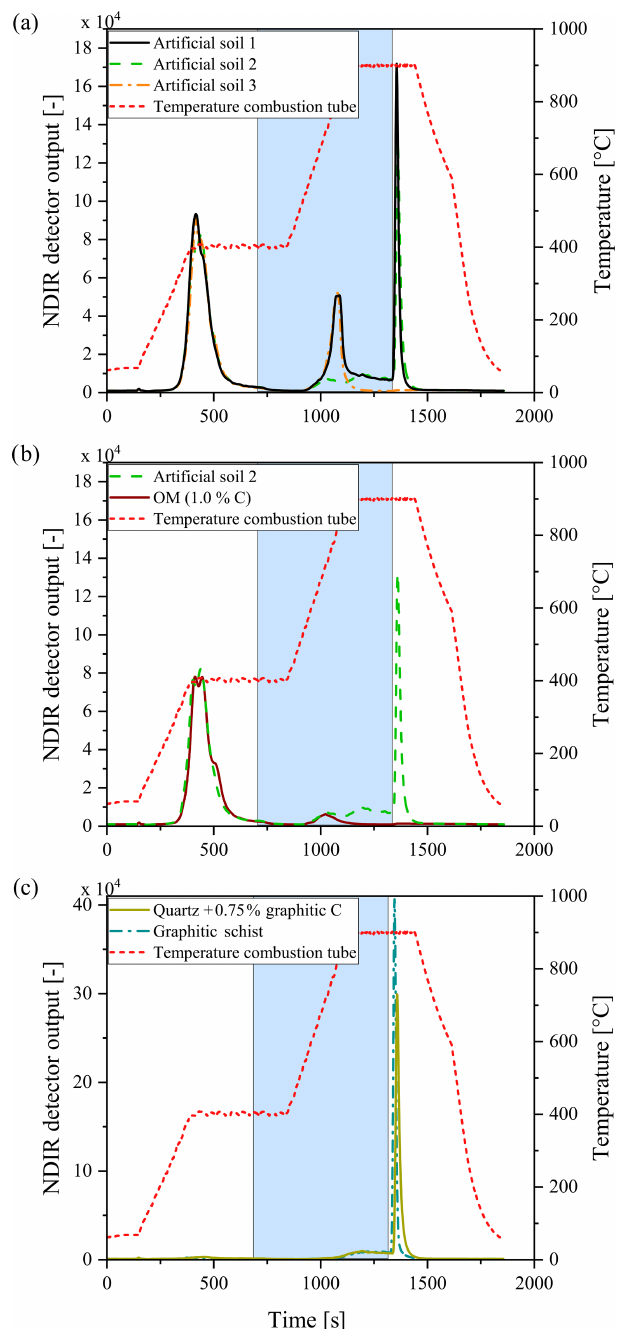
Figure 8. Examples of smart combustion measurements of the arti- ficial soils (a) , the fresh OM component (b) , and the graphite stan- dard and graphitic schist (c) . The blue area delineates the interval where O 2 gas is substituted for N 2 . The temperature program is displayed by the red dashed line. Note that artificial soil 2 (green) is without CaCO 3 and artificial soil 3 (orange) is without